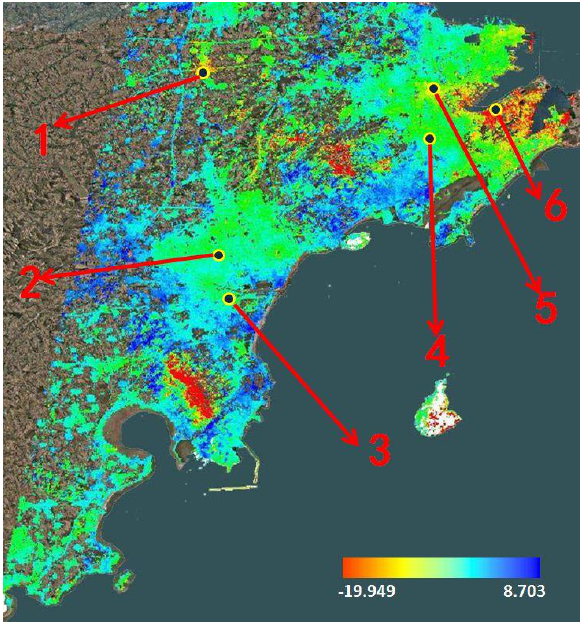
Figure 6. The annual average sedimentation rate map from